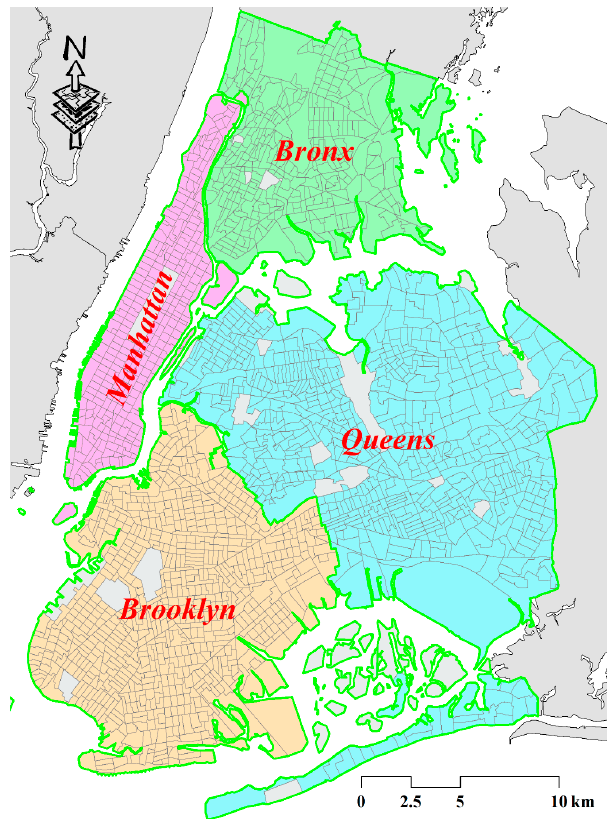
Figure 1. Study Area.